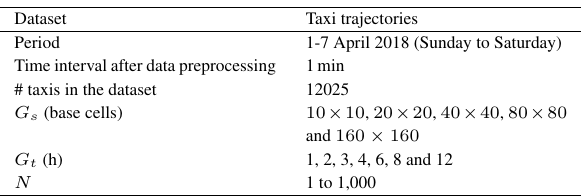
Table 1. Data and experimental